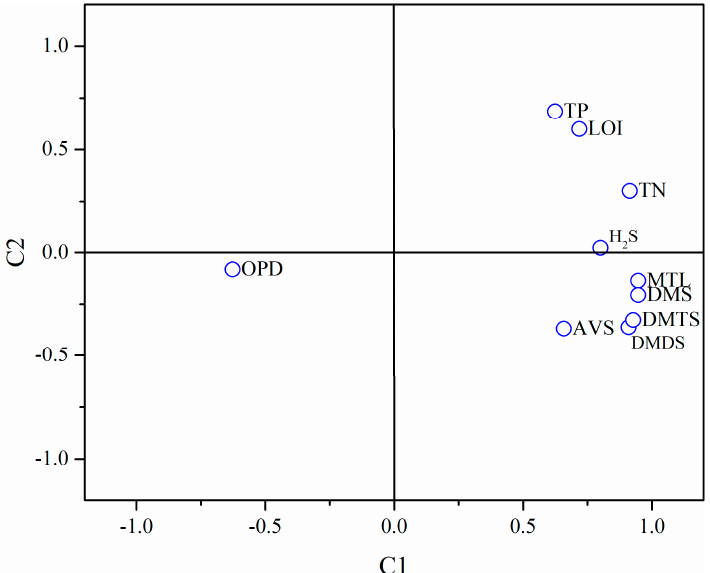
Figure 7. Principal component analysis (C1, C2) of the various characteristics of water and sediments for the field investigation period. OPD: Oxygen penetration depth; TP: Total phosphorus in the sediment; LOI: Loss on ignition in the sediment; TN: Total nitrogen in the sediment; AVS: Acid volatile sulfide in the sediment; H 2 S: Hydrogen sulfide in the water; MTL: Methanethiol in the